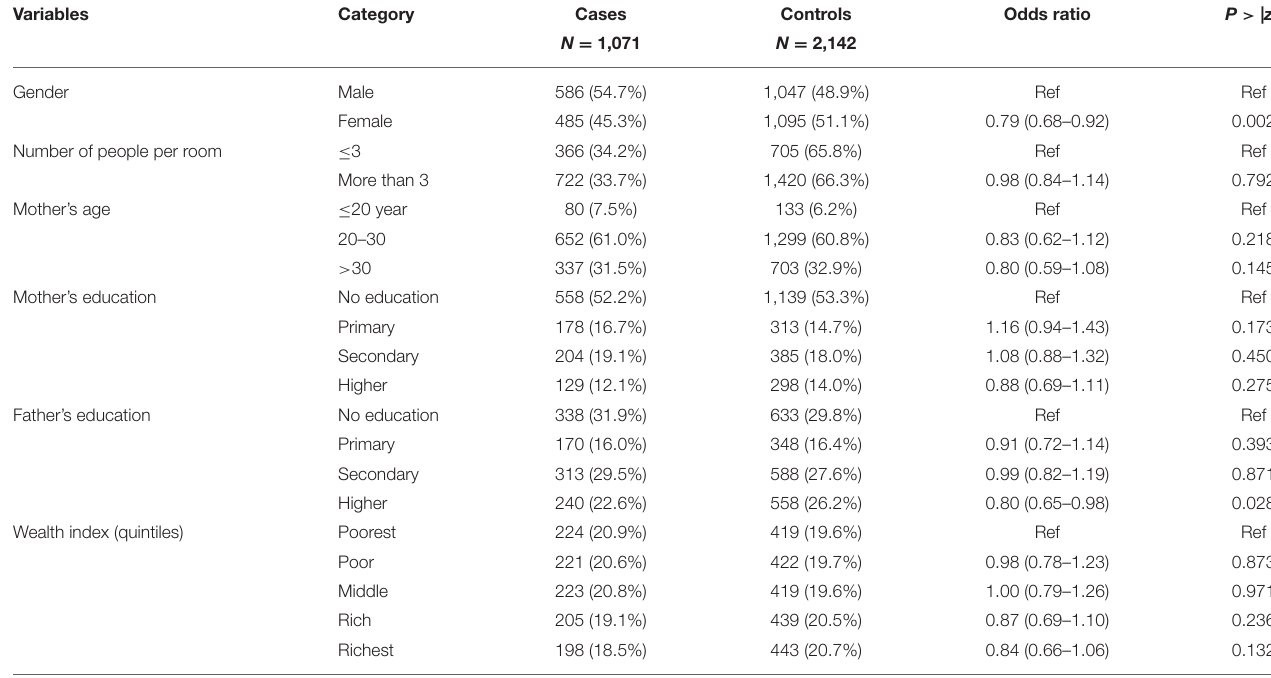
TABLE 2 | Descriptive and univariate analysis of demographic and socioeconomic characteristics of households associated with ARI.